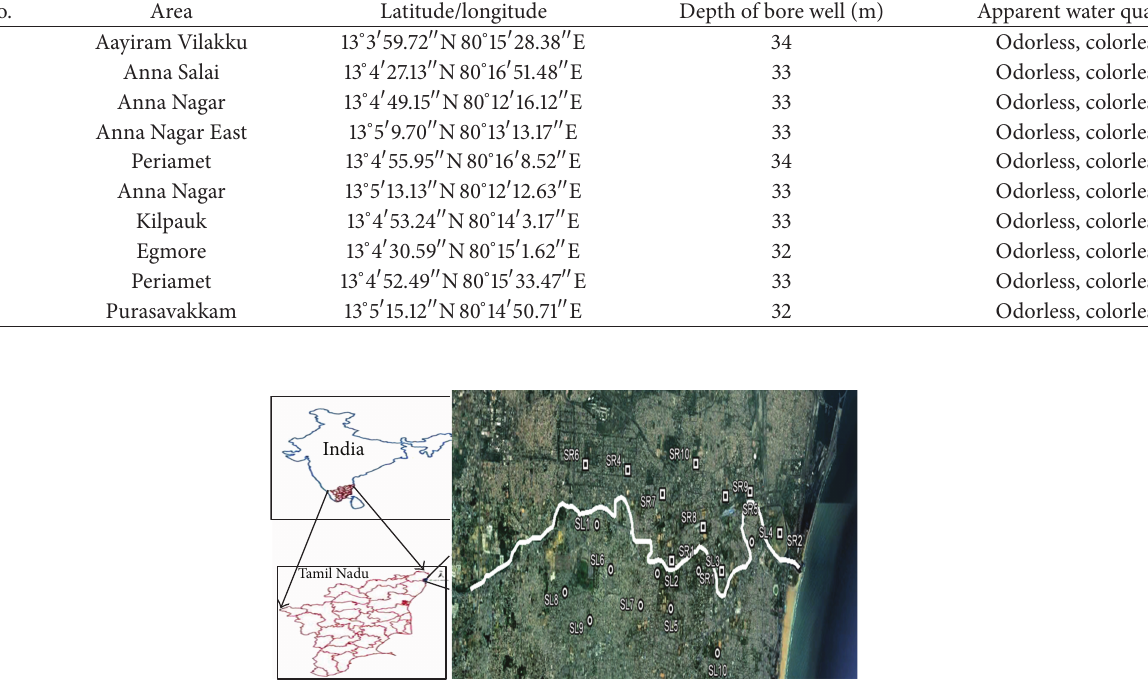
Figure 1: A map showing sampling locations along the Cooum